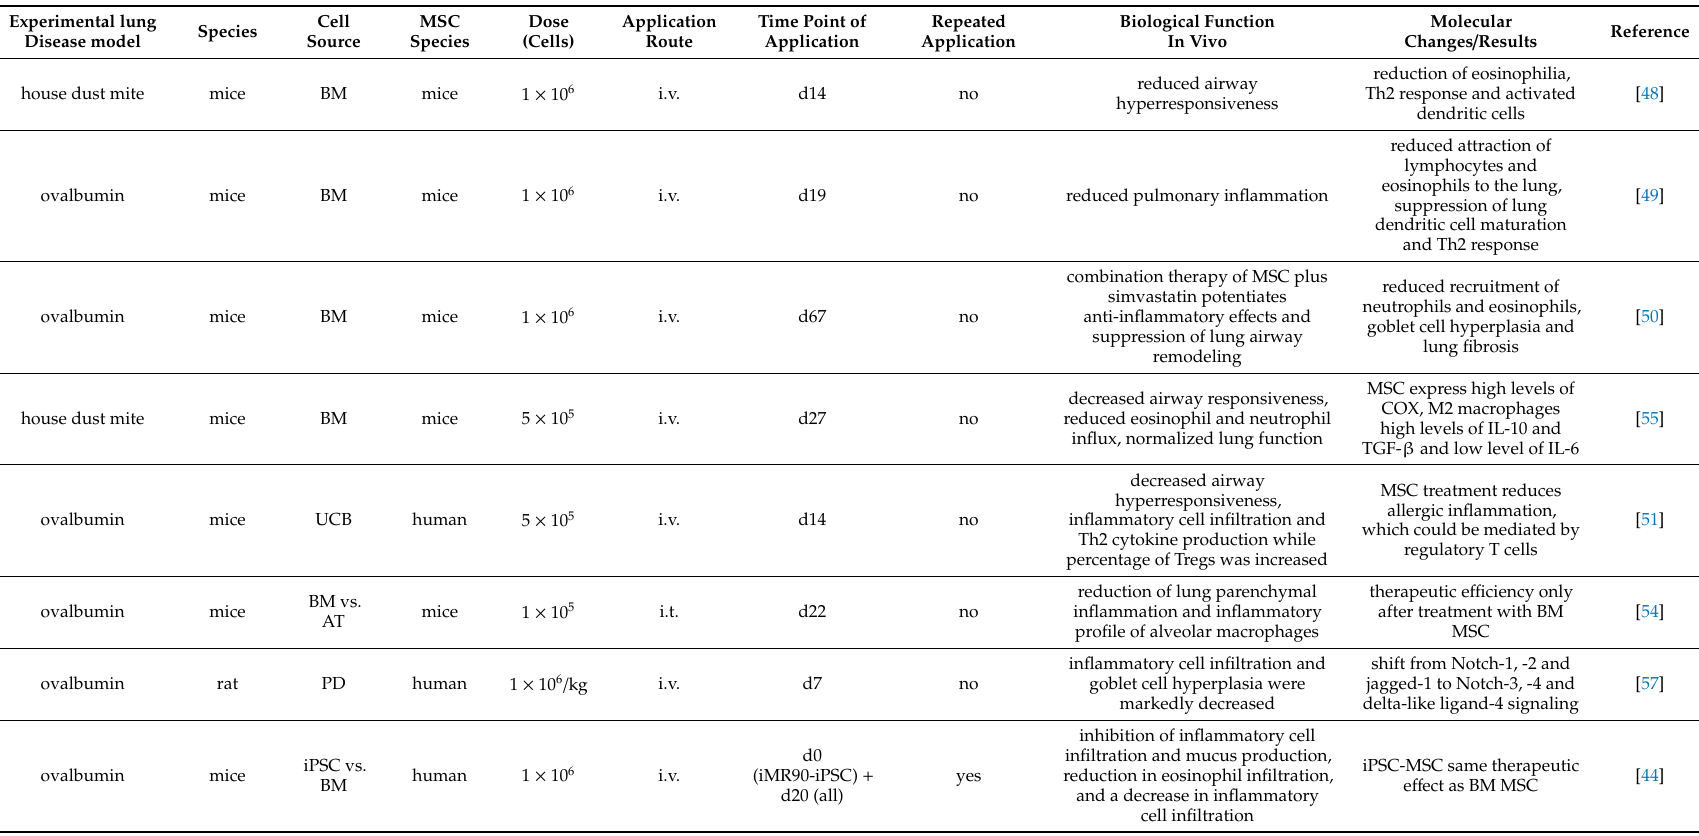
Table 2. Summary of decisive preclinical studies in rodents examining the therapeutic potential of MSC to treat